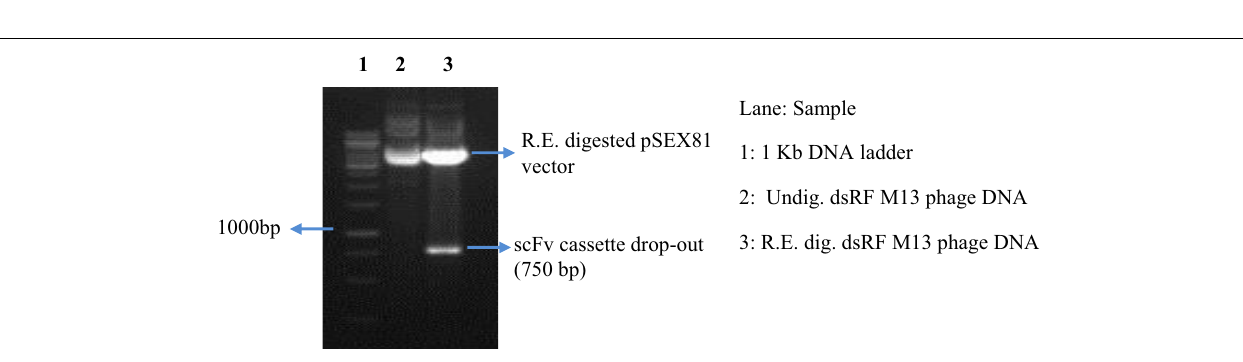
FIGURE 3 | Cloning of the complete scFv cassette in the pSEX81 phagemid vector . The phage-display library of the murine scFv gene pool was constructed by insertion of the antibody light and heavy chain gene DNA into the phagemid pSEX81 vector. Lane 3 represents the drop-out of the scFv DNA upon restriction digestion with the restriction enzymes, Nco I and Not I, flanking the scFv